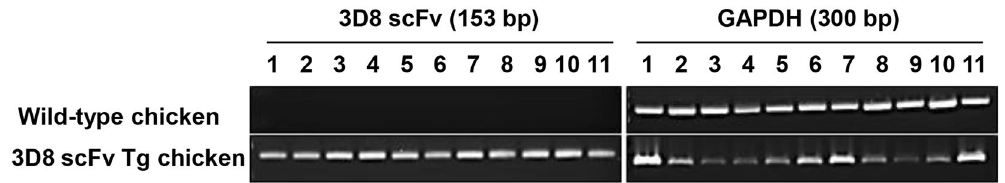
Figure 2. RT-PCR analysis of 3D8 scFv mRNA in transgenic and wild-type chicken tissues. 3D8 scFv mRNA is present in the trachea (1), ovary/testis (2), kidney (3), spleen (4), pancreas (5), brain (6), lung (7), liver (8), heart (9), muscle (10), and intestines (11).